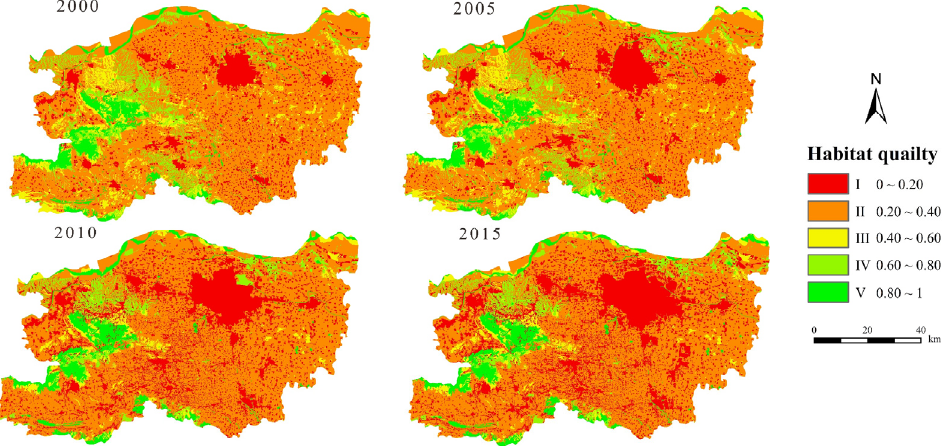
Figure 3. Spatial distribution of habitat quality during the different periods from 2000 to 2015.